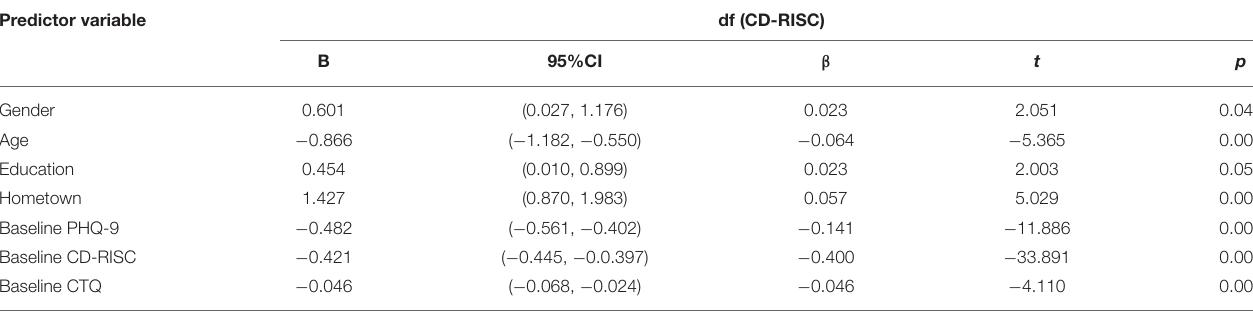
TABLE 3 | Independent predictors of changes in scores of CD-RISC through military-style training. Predictor